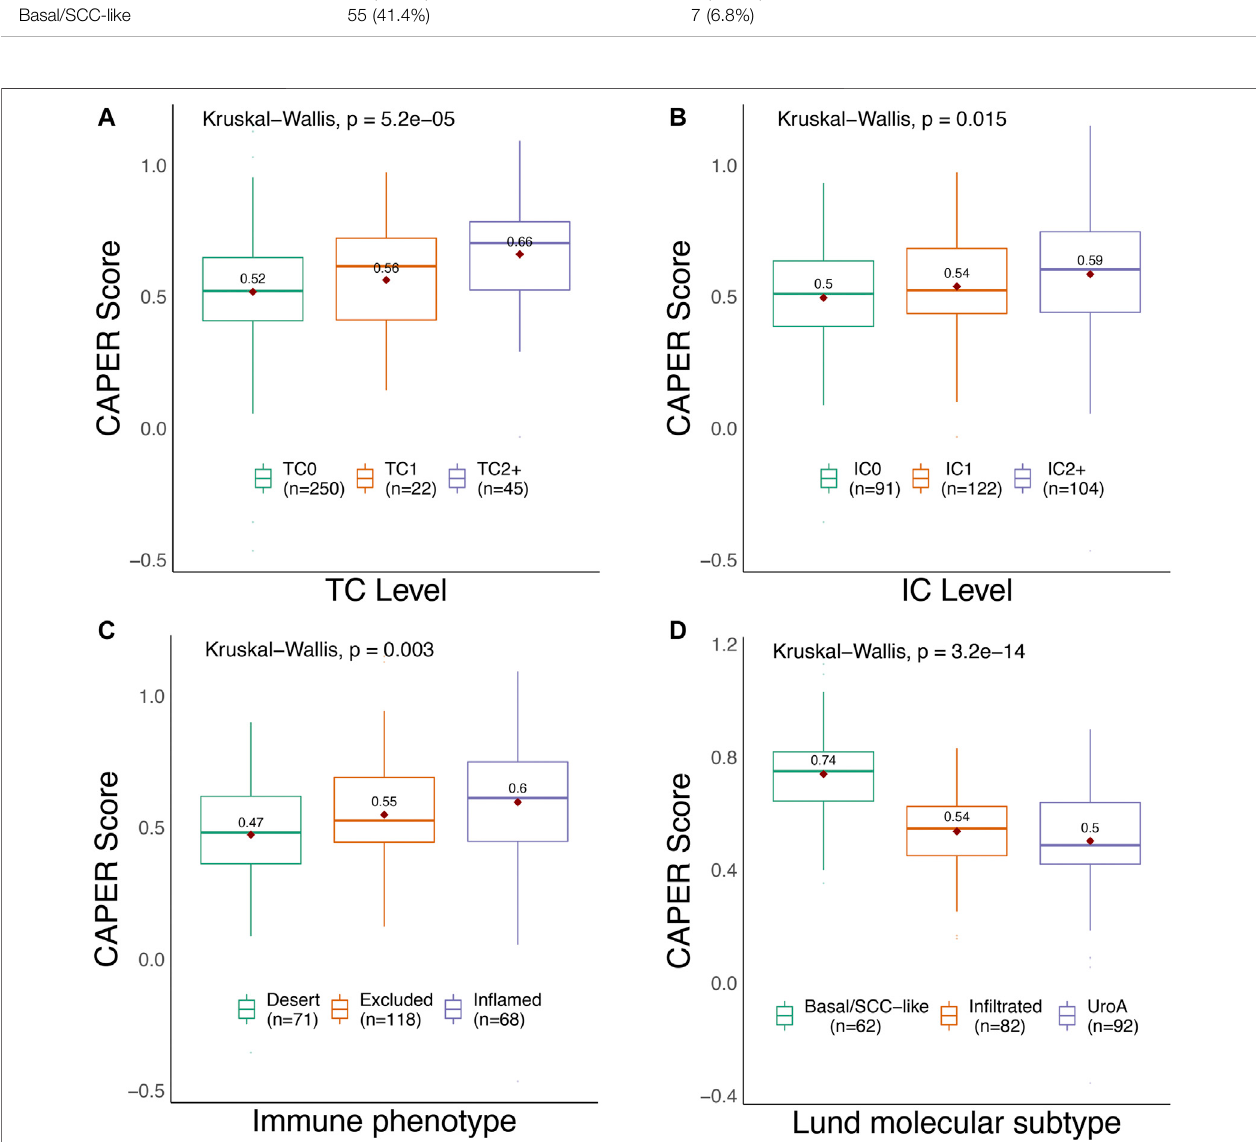
FIGURE 6 | Summary of the differences between the four tumor phenotypes in different CAPER groups using IMvigor210. (A) TC levels; (B) IC levels; (C) immune phenotypes; (D) Lund molecular subtypes.